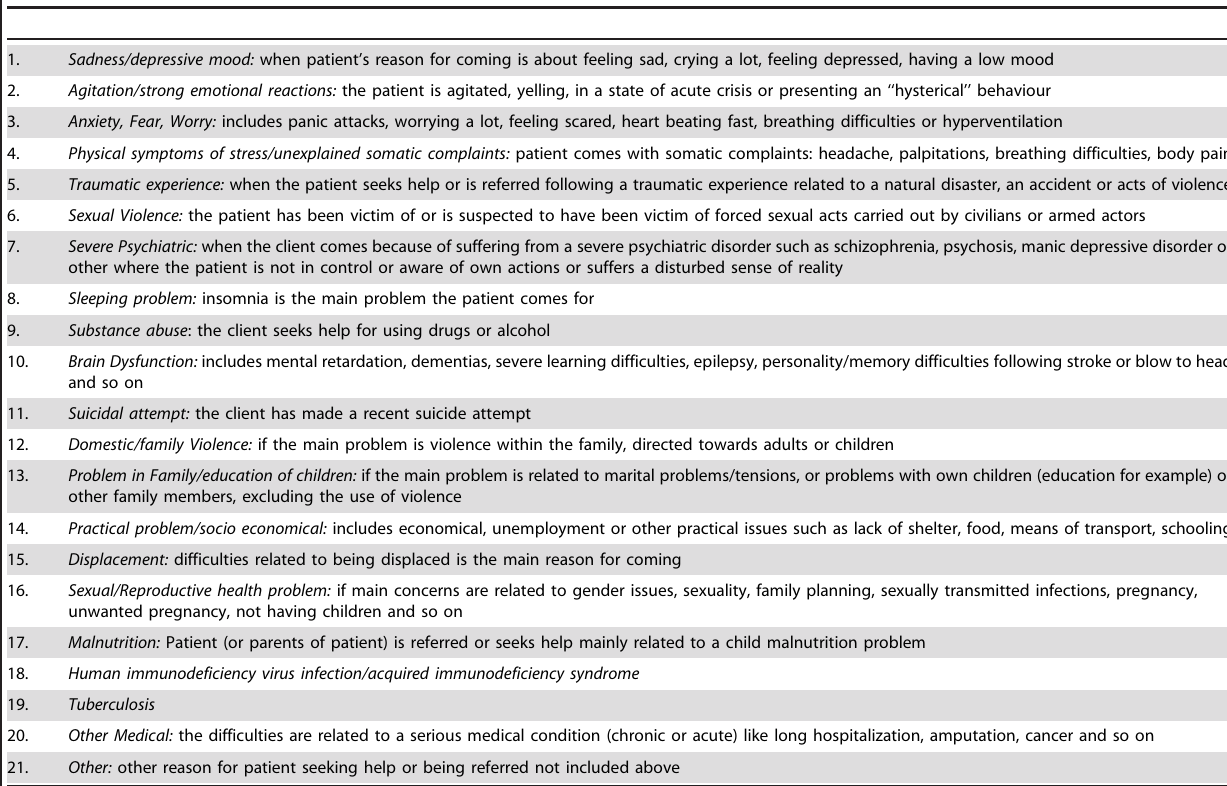
Table 1. Patients reasons for seeking mental health care according to standardized guidelines 1 in Timurgara district hospital, Pakistan